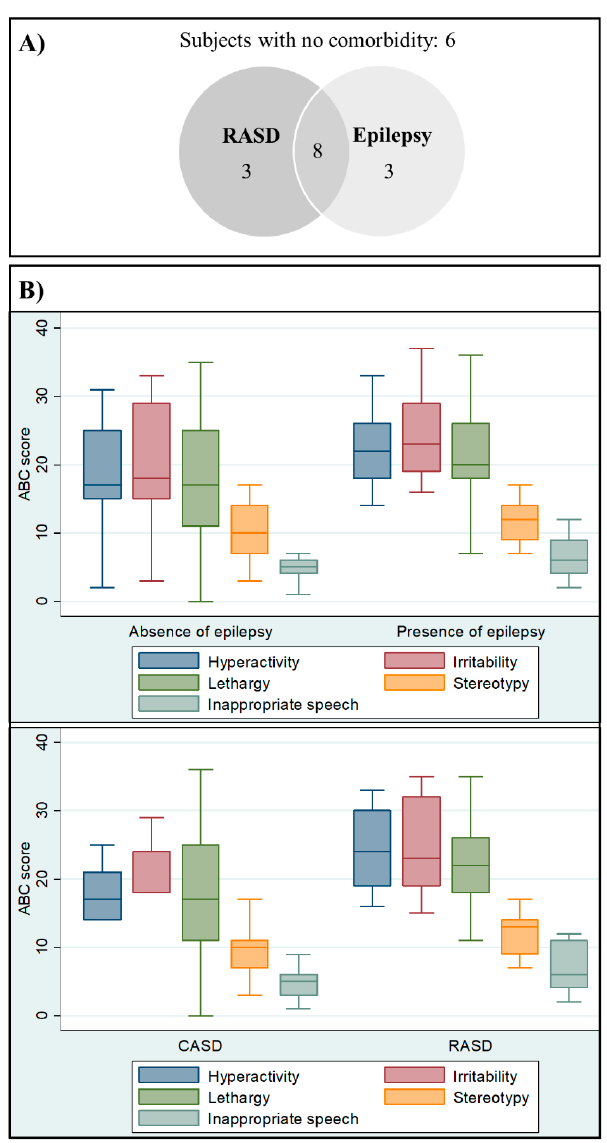
Figure 2. ( A ) Number of subjects with RASD, epilepsy, and both conditions are displayed. ( B ) Boxplots representing the difference of ABC median scores and the 25th–75th percentile of ABC scores in subjects stratified by epilepsy absent/present and CADS/RASD.